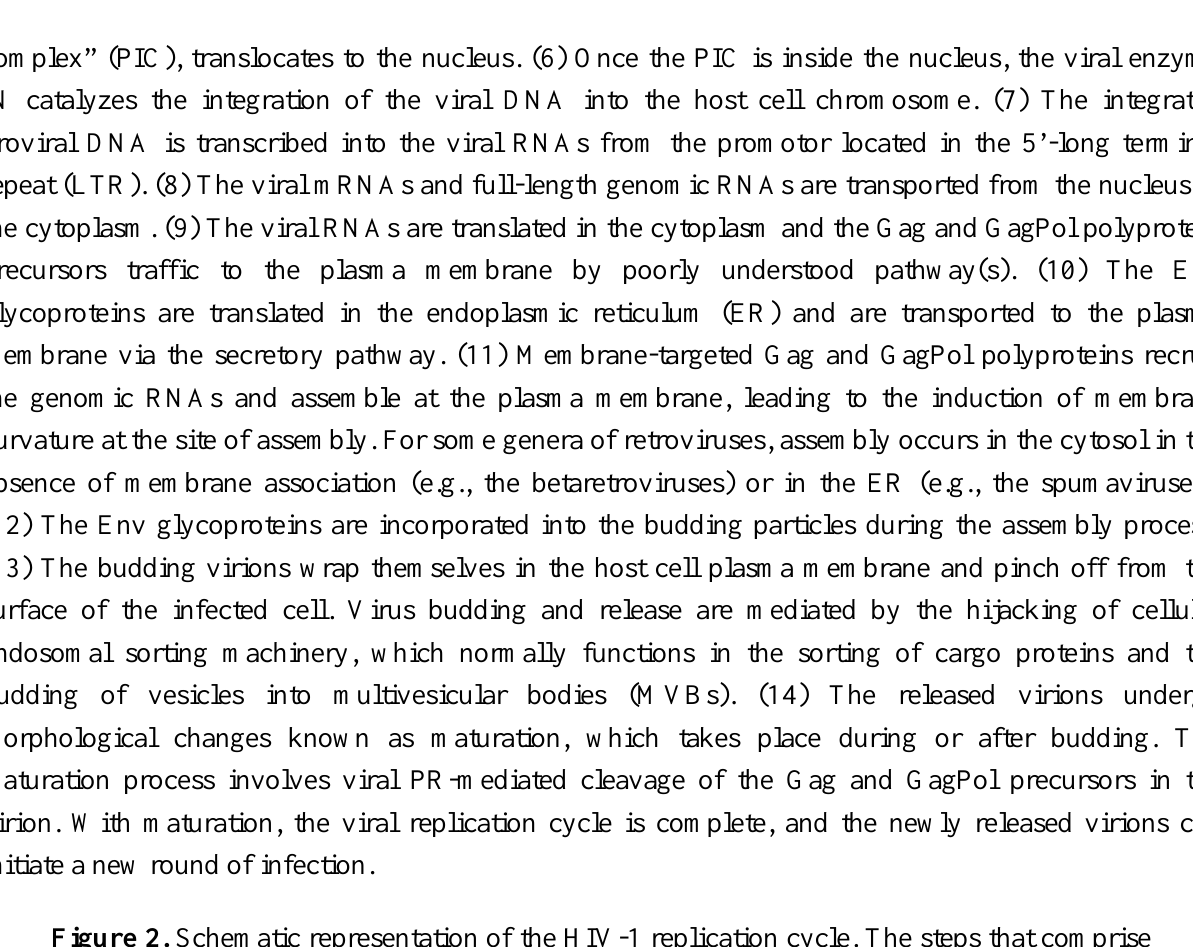
Figure 2. Schematic representation of the HIV-1 replication cycle. The steps that comprise the replication cycle are described in more detail in the text. Reprinted with permission from Freed [221]. Copyright 2004 Elsevier